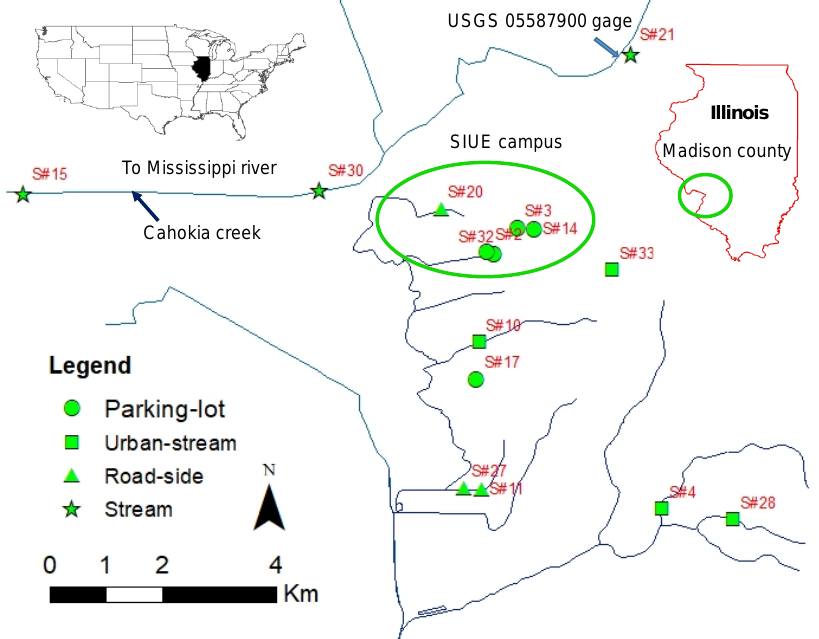
Figure 1. Location of sensors at different waterbody sites (Stream, Urban-stream, Roadside drain, and Parking-lot drain) and USGS 05587900 gage. Sensor# 22 (Stream) and # 8 (Roadside) are not visible on the map due to scale adjustment. Sensors were calibrated and validated in a lab before their deployment in the field [15,19]. Furthermore, we also validated sensor measured field concentrations with a standard Hach conductivity meter manufactured by the Hach Company (https://www.hach.com/ accessed on 14 January 2021). The average errors between sensor and standard Hach meter salt concentrations were less than 5% but varied from 0 to 13% for the laboratory validation. Whereas average errors were between 9% to 12% and varied from 1% to 30% for field validations [15]. Salt concentrations in waterbodies vary spatially such as at near roads, urban areas, distance from highways/roadways and below parking lots, etc. [7,9,33–35]. Since, one of the main objectives of the study is to analyze spatial and temporal variability of salt con- centrations within the site and between different sites, we deployed sensors at stream, urban-stream, roadside drain, and parking-lot drain locations. The locations for sensor deployment were selected based on the site available for sensor installation, safe from direct human reach, accessibility, and expected salt runoff during winter months. A total of 35 sensors were deployed in different locations around Madison County [19]. However, only 17 sensors were analyzed in this study because some of the deployed sensors were vandalized (three), malfunctioned (two), damaged due to excessive flow force (two), and dry locations (two) during most of the measurement period (Figure 1). 2.2.1. Stream The stream site (Cahokia Creek) considered in this study is a perennial waterbody, where flow occurs all season. The study is focused on Cahokia Creek (about 35 m wide), which drains into the Mississippi River at the Lewis and Clark memorial park. The daily mean discharge is 4.15 m 3 /s based on the 50 years of records at the USGS 05587900 gage